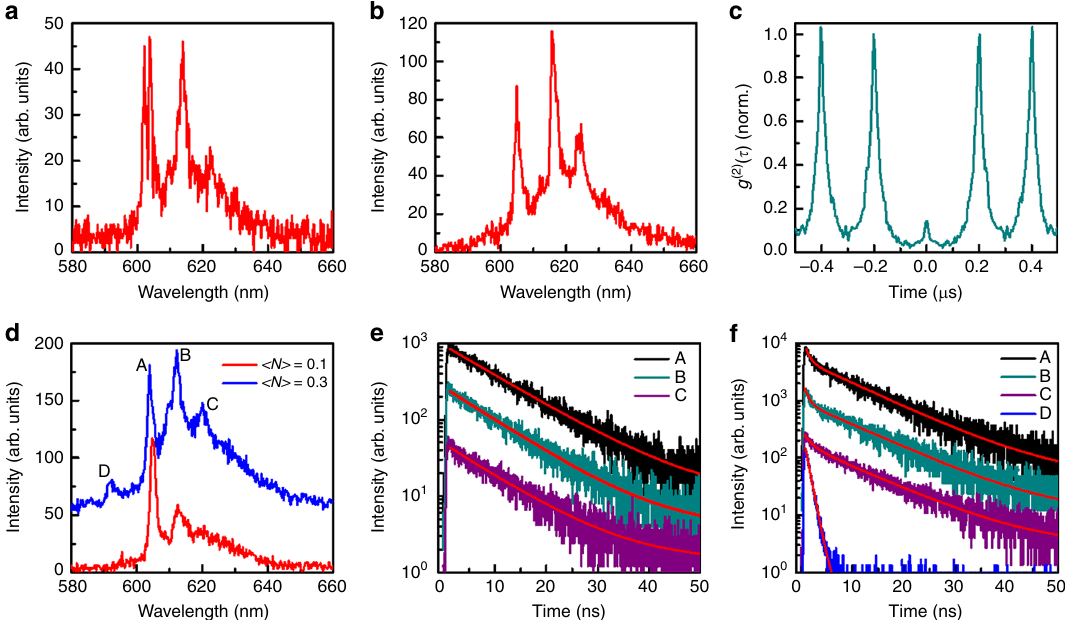
Fig. 3 Optical properties of single gNCCs at 4 K. a , b PL spectra of two single gNCCs excited at < N > = 0.1. c Second-order photon autocorrelation measurement of a single gNCC with a g (2) ( τ ) value of about 0.15 at the zero-time delay. d PL spectra of a single gNCC excited at < N > = 0.1 and 0.3, respectively. e PL decay curves measured at < N > = 0.1 for the A, B, and C emission peaks of this single gNCC and fi tted with single-exponential lifetimes of 10.9, 10.0, and 10.1 ns, respectively. f PL decay curves measured at < N > = 0.3 for the A, B, and C emission peaks of the same single gNCC. These curves are all fi tted by biexponential functions with the fast/slow lifetimes of 0.8/10.1, 0.7/10.5, and 1.1/10.1 ns, respectively. The PL decay curve of an additional emission peak of D is also presented and fi tted with a single-exponential lifetime of 0.9 ns